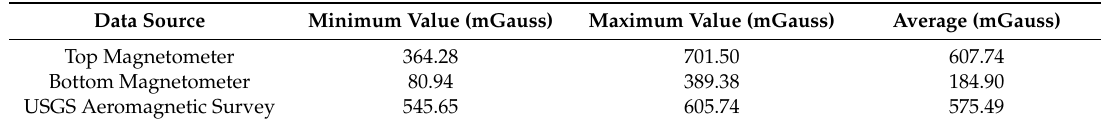
Table 1. A comparison of magnetic values collected from each magnetometer of the magnetic gradiometer, compared with USGS aeromagnetic survey of the same area.